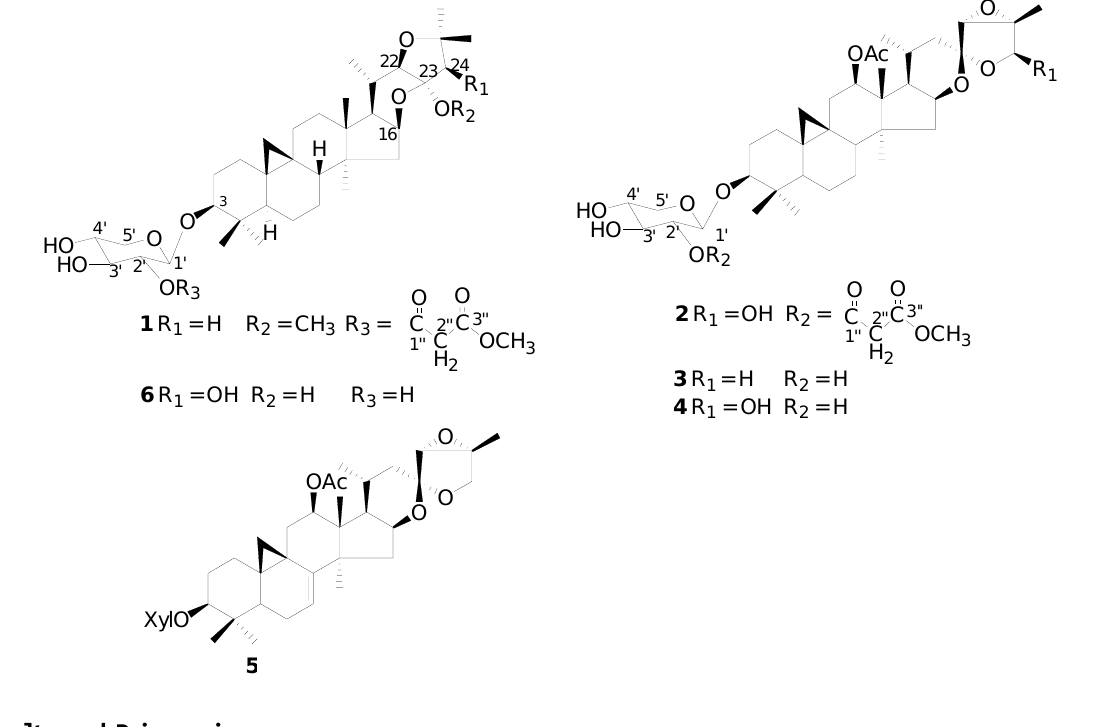
Figure 1. Chemical structures of triterpenoid glycoside from the C.